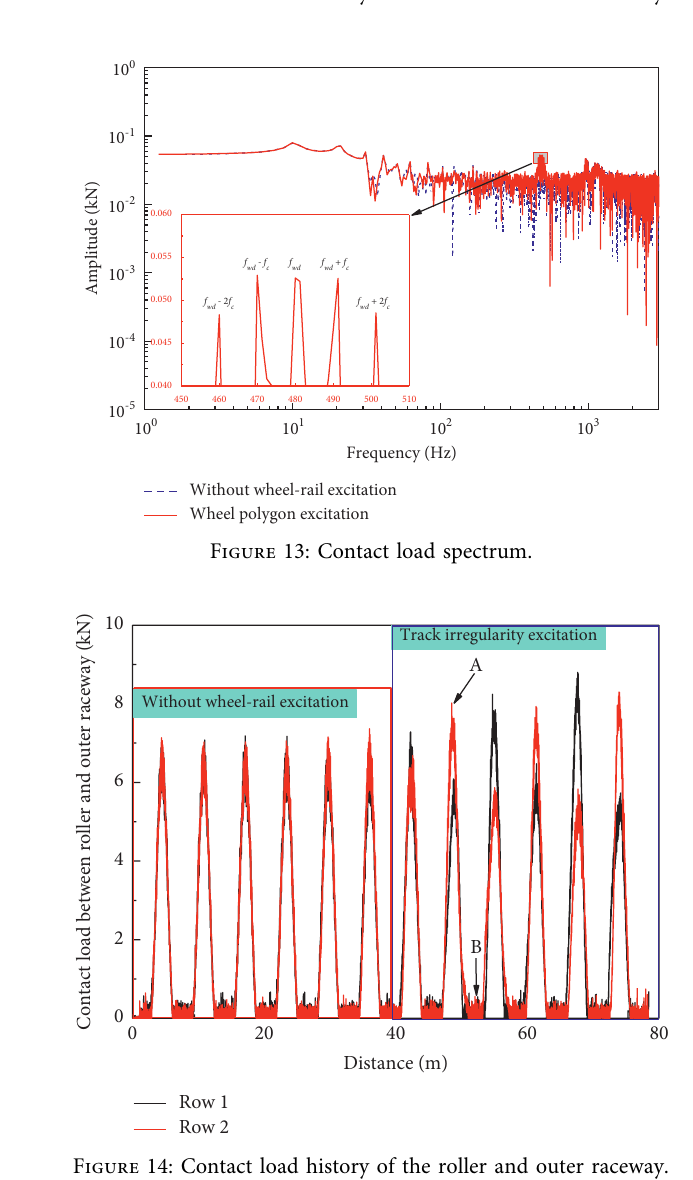
Figure 12: Contact load history of the roller and outer raceway.